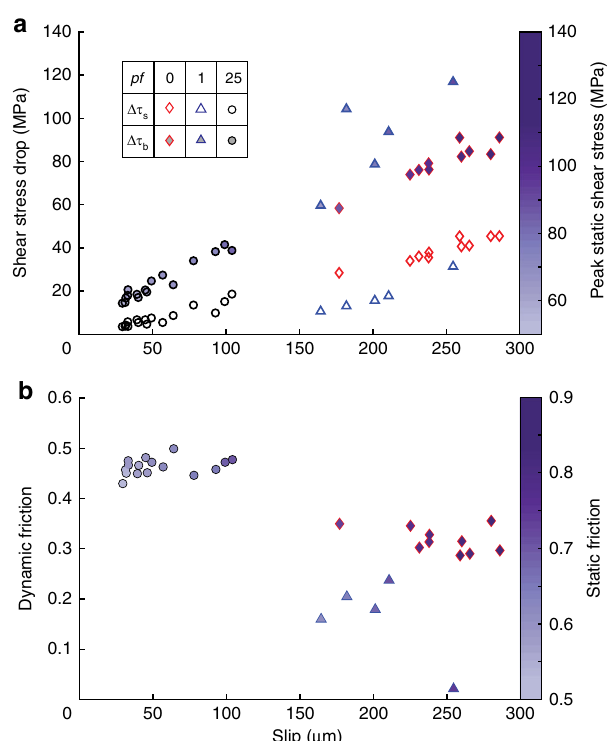
Fig. 2 Compiled data for experiments at σ 3 ’ = 70 MPa. Red diamonds account for dry events, blue triangles for low fl uid pressure events and black circles for high fl uid pressure events. a Compiled data of Δ τ s (static shear stress drop, empty markers) and Δ τ b (breakdown shear stress drop, full markers) against on-fault resolved slip. Colour bar accounts for τ 0 (static shear stress reached at the onset of the instability, i.e. amount of elastic energy stored in the system). b Dynamic friction resolved against the on-fault total event slip. Colour bar accounts for static friction reached at the onset of